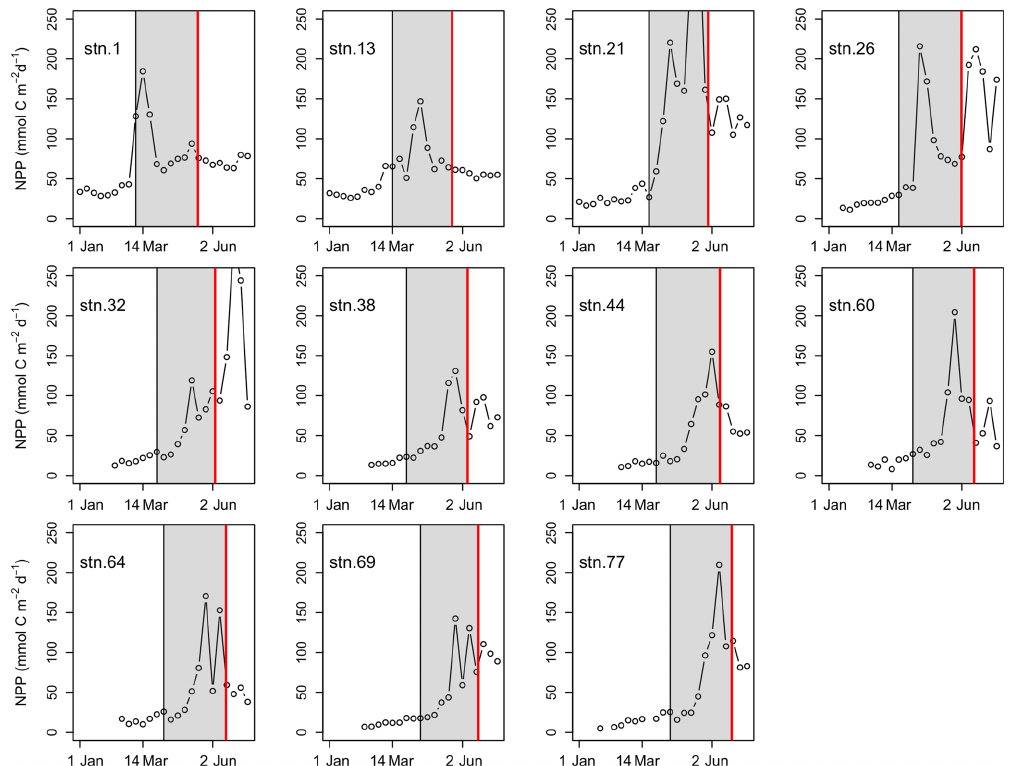
Figure 6. Time-series (1 January–12 July 2014) satellite estimates of net primary production (NPP) between 1 January and 12 July in 2014 at each station along the GA01 transect (VPGM algorithm, http://www.science.oregonstate.edu/ocean.productivity/, last access: 18 January 2019). The shaded rectangle in each plot denotes NPP for about 2 months prior to the sampling date. Two months of NPP data are needed because this timescale could ensure the sensitivity for NSS estimates (Friedrich and Rutgers van der Loeff, 2002; Stewart et al., 2007). The vertical red line in each plot indicates the sampling date at each